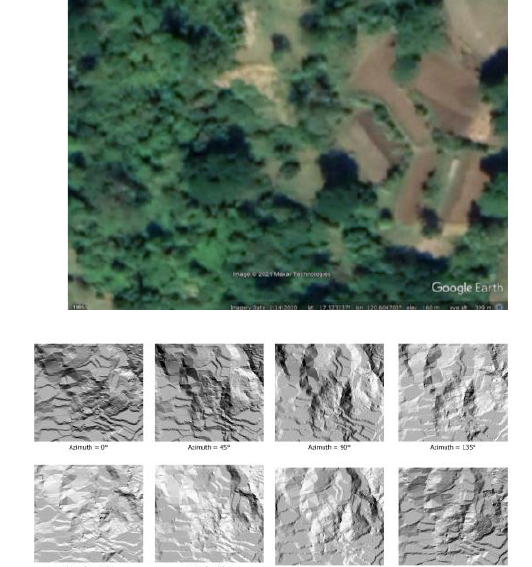
Figure 5 . Google Earth satellite image (top) DTM in different azimuths (bottom) .